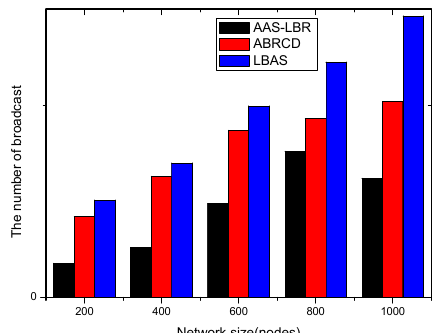
Figure 39. The impact of network size with fixed |𝑇| = 150 on the number of broadcasts.